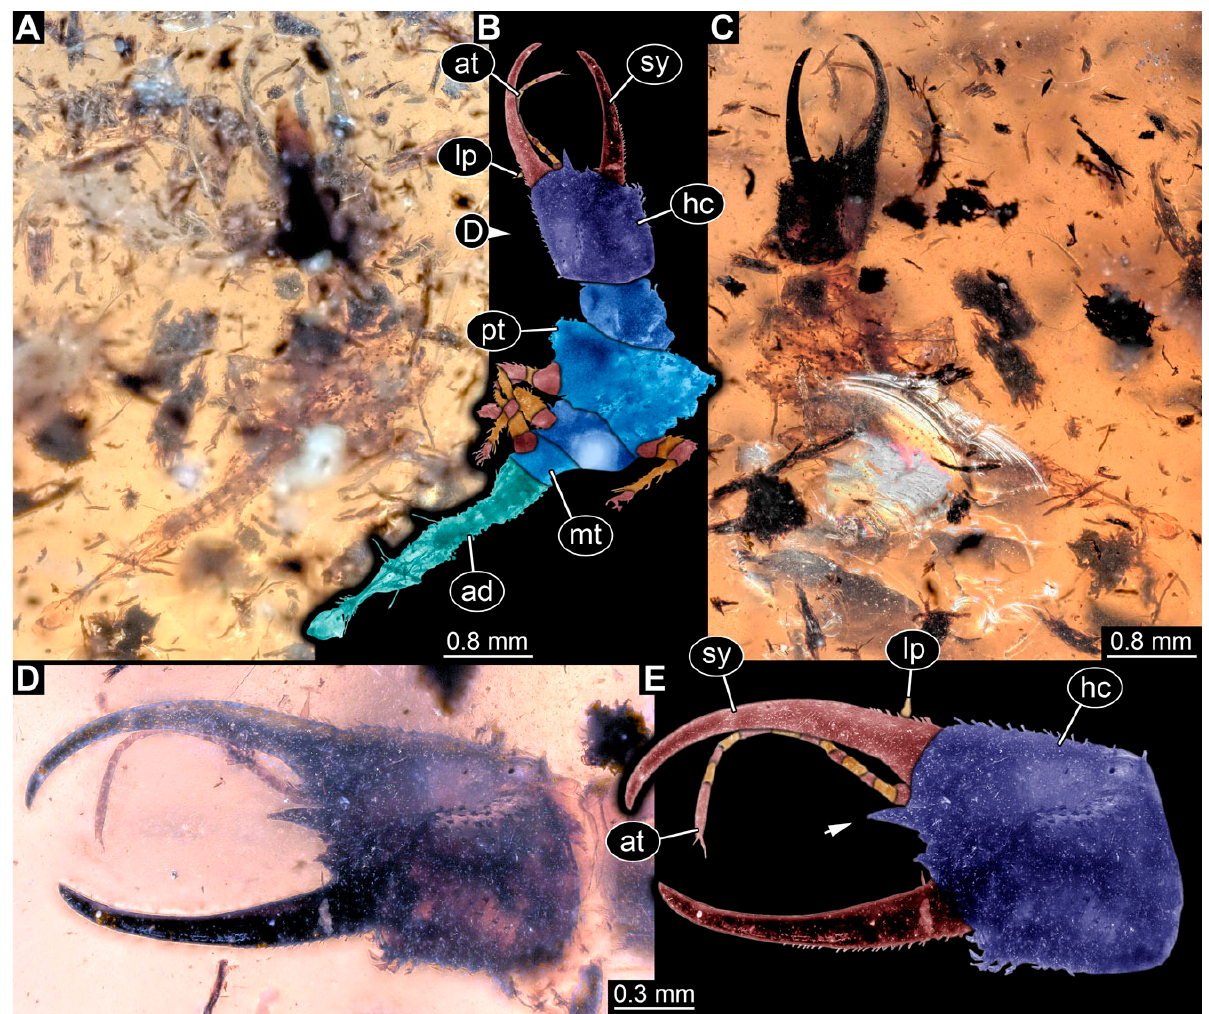
Figure 9. Specimen 66 (PED 0621); Myanmar amber. ( A ) Dorsal view. ( B ) Dorsal view, colour-marked. ( C ) Ventral view. ( D ) Close-up of head capsule in ventral view. ( E ) Close-up of head capsule in ventral view, colour-marked; arrow marks middle spine-like protrusion. Abbreviations: ad = abdomen; at = antenna; hc = head capsule; lp = labial palp; mt = metathorax; pt = prothorax; sy =